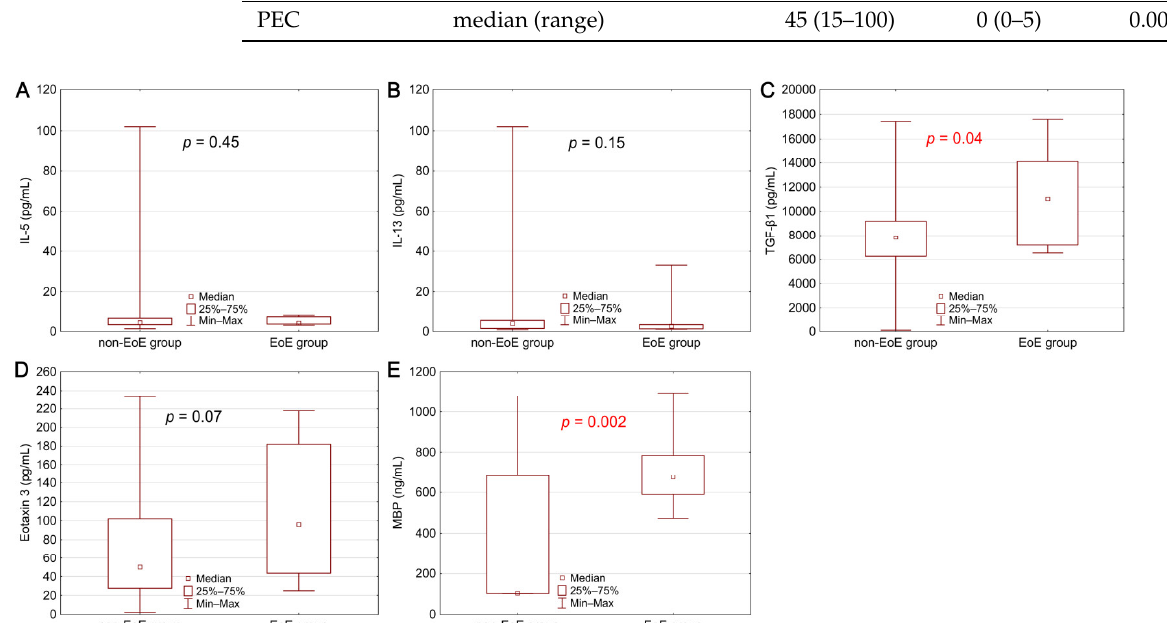
Figure 1. Comparison of serum biomarker concentrations between the group of patients with EoE and the non-EoE group: ( A ) interleukin 5—IL-5, ( B ) interleukin 13—IL-13, ( C ) transforming growth factor β1—TGF-β1, ( D ) eotaxin 3, ( E ) major basic protein—MBP. Statistical significance was evaluated with a Mann–Whitney U test.